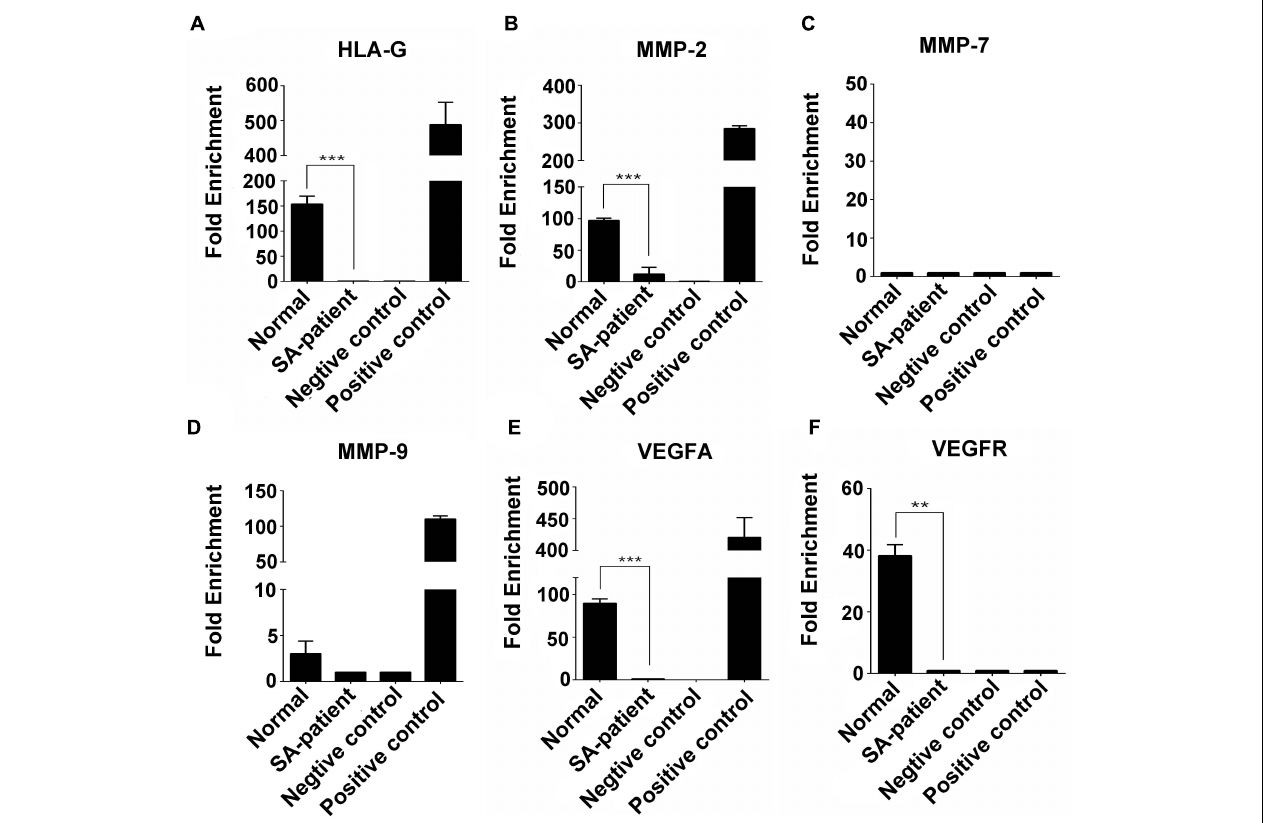
FIGURE 9 | Fold-change in YTHDF2-bound (A) HLA-G , (B) MMP2 , (C) MMP7 , (D) MMP9 , (E) VEGFA , and (F) VEGFR mRNA in the chorionic villi of the indicated groups. (Normal n = 9; Patient n = 9, ** P < 0.01, *** P <